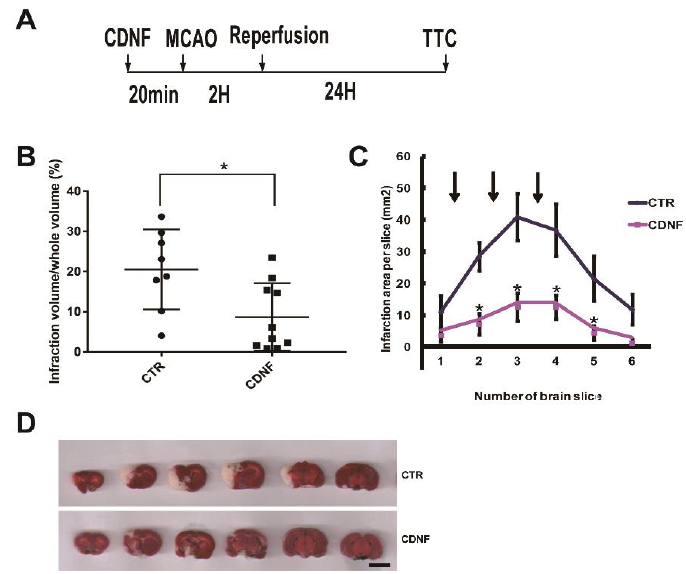
Figure 1. The local cortical CDNF pretreatment significantly reduced the cerebral infarction volume induced by MCAO. ( A ) Experimental scheme for the MCAO rats. CDNF protein or vehicle was administered intracerebrally into three cortical sites approximately 20 min before MCAO. The left middle cerebral artery (MCA) was occluded with a nylon filament for 120 min, and the filament was withdrawn to allow for 24 h of reperfusion. Then, the brains were removed and sliced into 2.0-mm thick sections for triphenyltetrazolium chloride (TCC) staining. ( B ) Pre-treatment with CDNF (6 μg) significantly decreased the infarct volume in the MCAO rats (control group, n = 8; CDNF group, n = 10). * p < 0.05 versus CTR. ( C ) The comparison of the infarction area per slice in each of the groups treated with CDNF ( n = 10) and PBS ( n = 8). The CDNF group significantly reduced the infarction area. Arrows represent the sites of injection. * p < 0.05 versus CTR. ( D ) TTC staining of brain sections. From left to right, the representative images were placed in order from the anterior to the posterior portion of the brain. Scale bar = 10 mm.